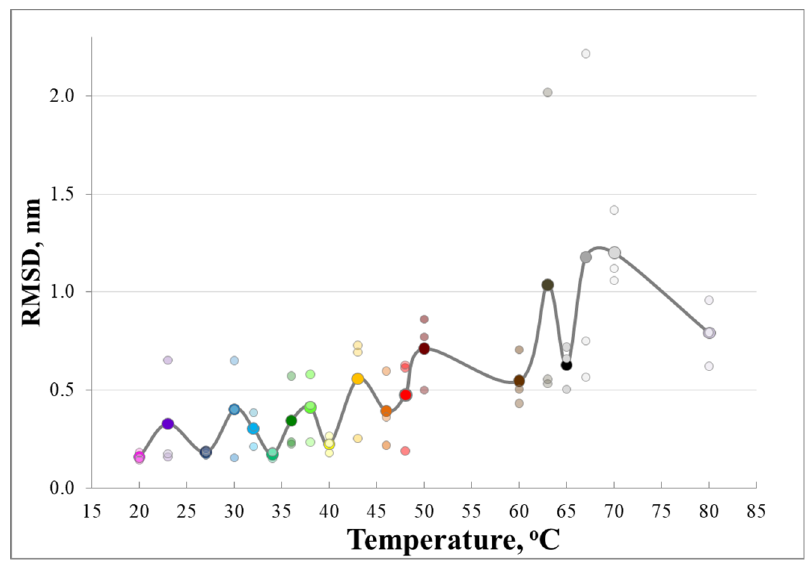
Figure 5. RMSD of proteinase K dimers averaged over C α atoms at different temperatures (from 20 to 80 °C). Saturated connected points represent data averaged over three independent simulations marked by unsaturated points.